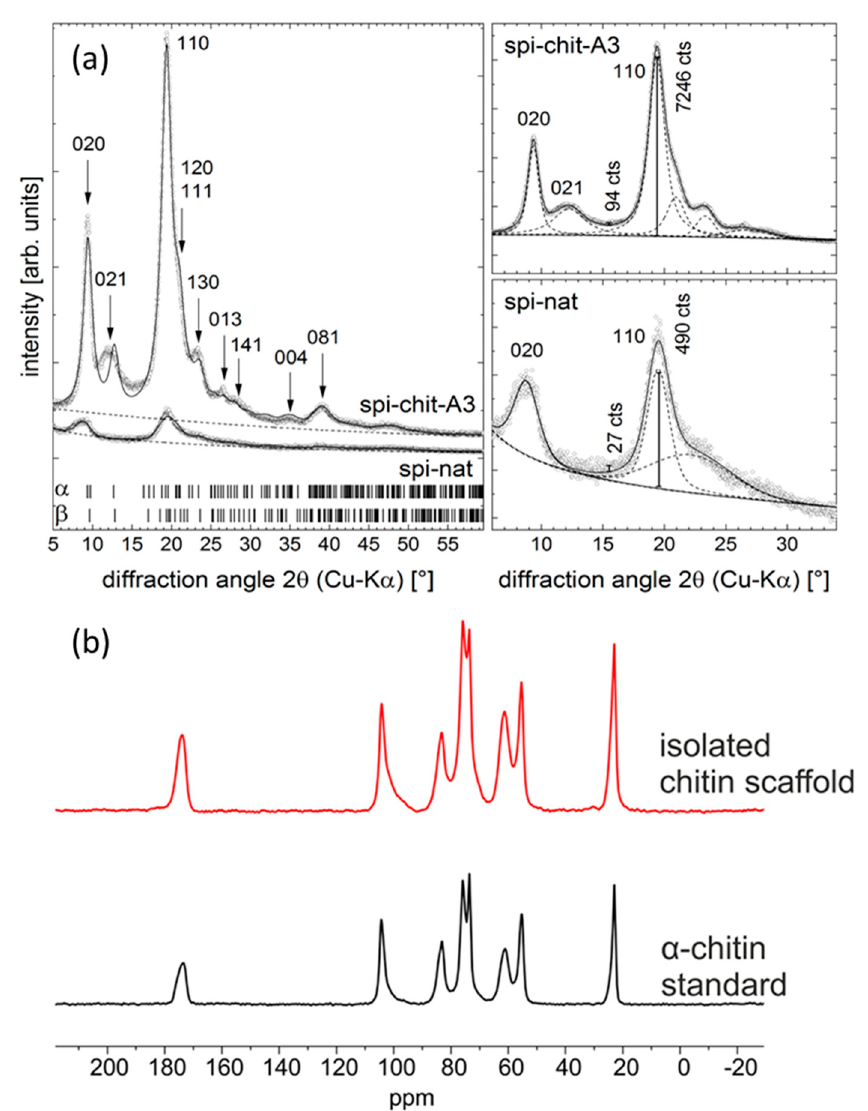
Figure 7. ( a ) Diffraction pattern of samples of natural molt cuticle (spi-nat) and isolated chitin scaffold (spi-chit-A3). The good match between experimental (dots) and calculated data (line) provides evidence for the presence of α -chitin (left, Rietveld refinement, phase identification). For comparison, the theoretical line positions for α - and β -chitin are also shown. The Laue indices of the most prominent diffraction maxima are given. The refinement involved a preferred orientation of α -chitin. The intensity measures used for the determination of the CrI are indicated in the patterns shown on the right (single peak fitting, dashed lines = individual peaks, solid line = sum profile, vertical bars = I am and I 110 determined at 2 θ ≈ 16° and 2 θ ≈ 19.5° respectively). ( b ) 13 C CP/MAS NMR spectra of isolated chitin scaffold (red line) and α -chitin (black line).